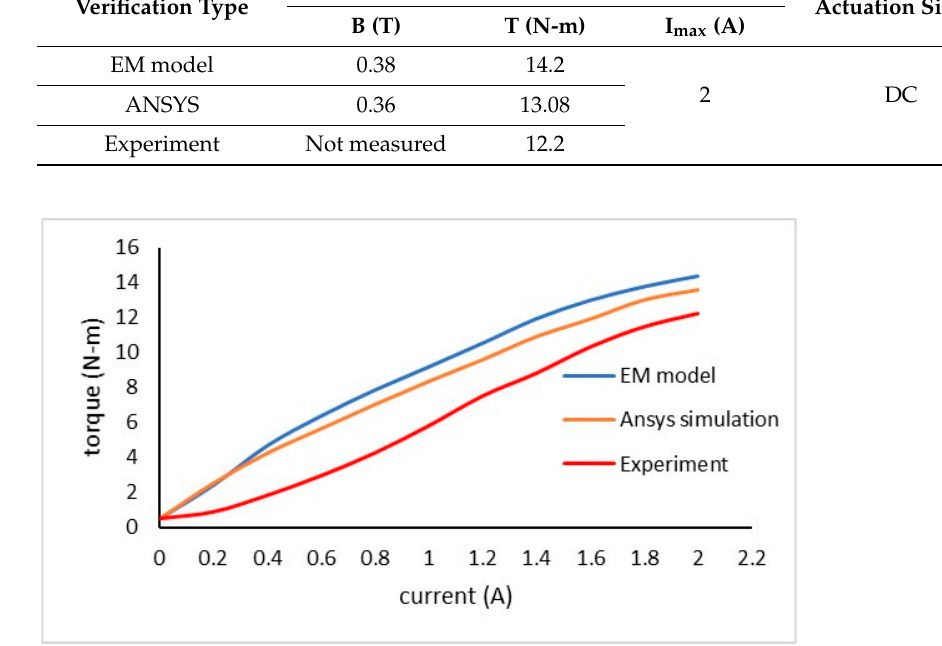
Table 1. Results of DC actuation signal.